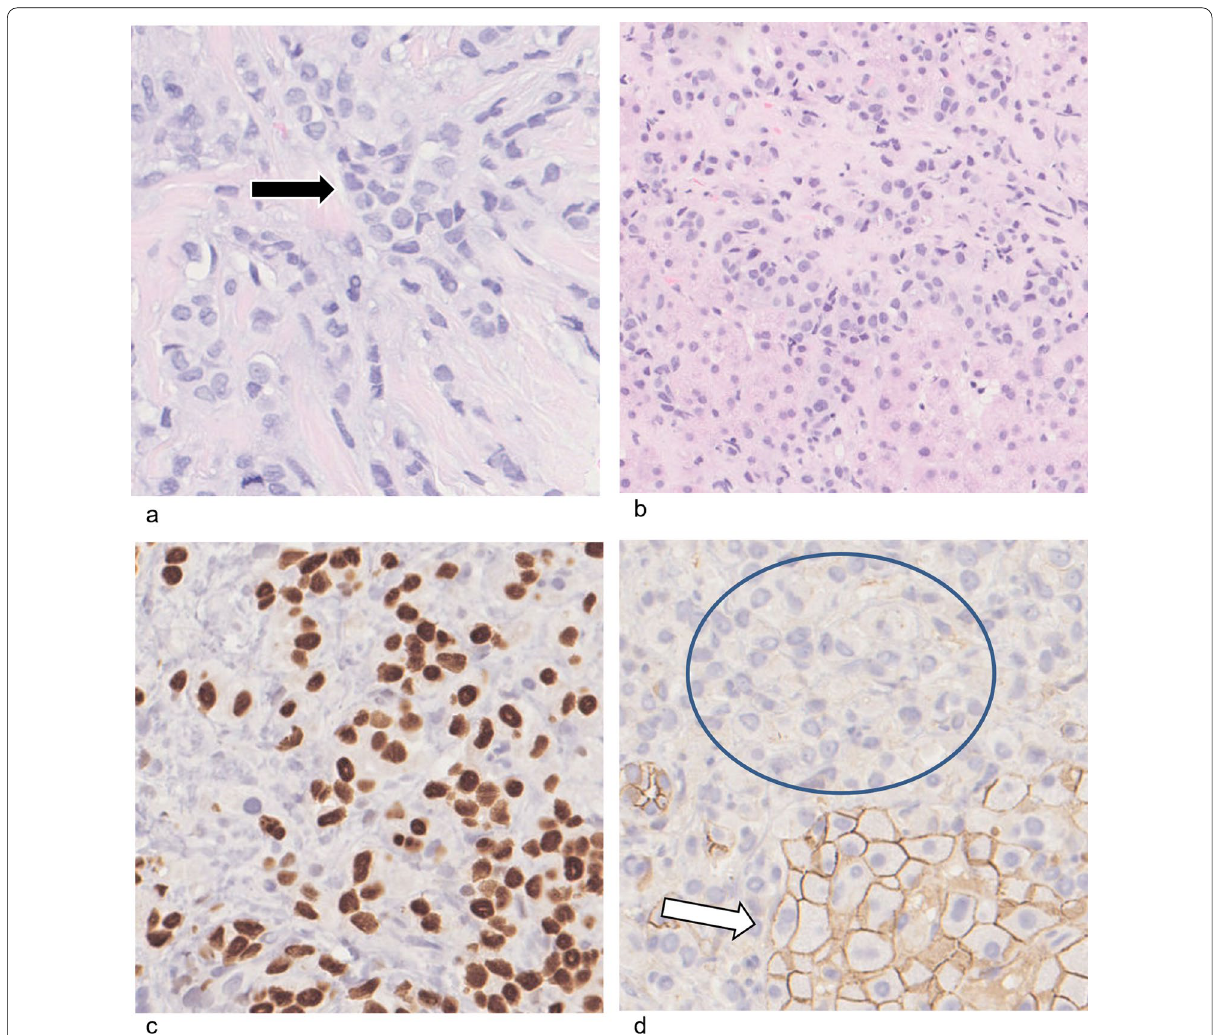
Fig. 1 Pathology and immunohistochemical staining of invasive lobular carcinoma. a In the breast: high power photomicrograph (H&E) shows the single-file appearance of primary ILC in the breast (black arrow). b In the liver: low power photomicrograph (H&E) demonstrates tumor cells infiltrating the liver. c In the liver: positive staining for GATA3 antibody suggests origin from the breast. d In the liver: negative E-cadherin staining of ILC cells (circled) and positively stained normal liver cells (white